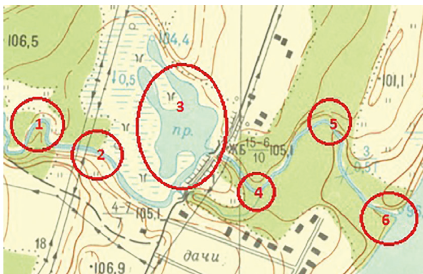
Figure 9: Section of River ˇ Zalesa is measured in the topographic maps (source: 1984 year topographic map. https://www.geoportal. lt/geoportal).